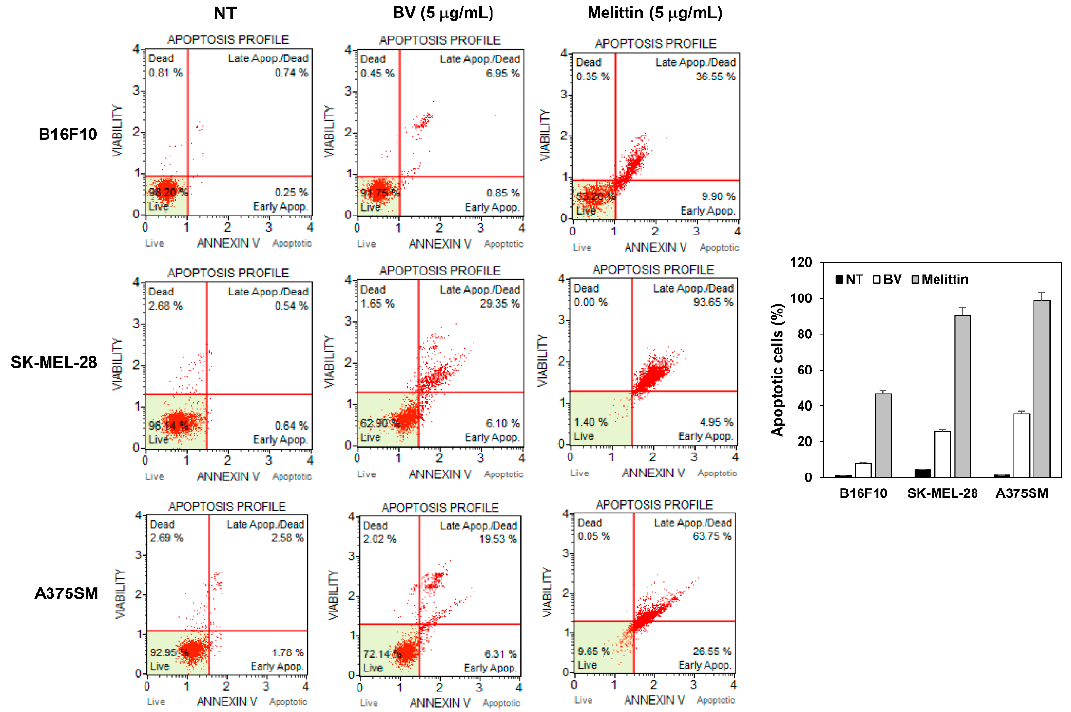
Figure 6. The effect of BV and melittin on the apoptotic cell death of melanoma cell lines. Cells were treated with BV and melittin for 24 h. Apoptotic cells were determined by flow cytometric analysis following annexin V-FITC and propidium iodide (PI) dual labeling. Each value represents the mean ± SE from three independent experiments.